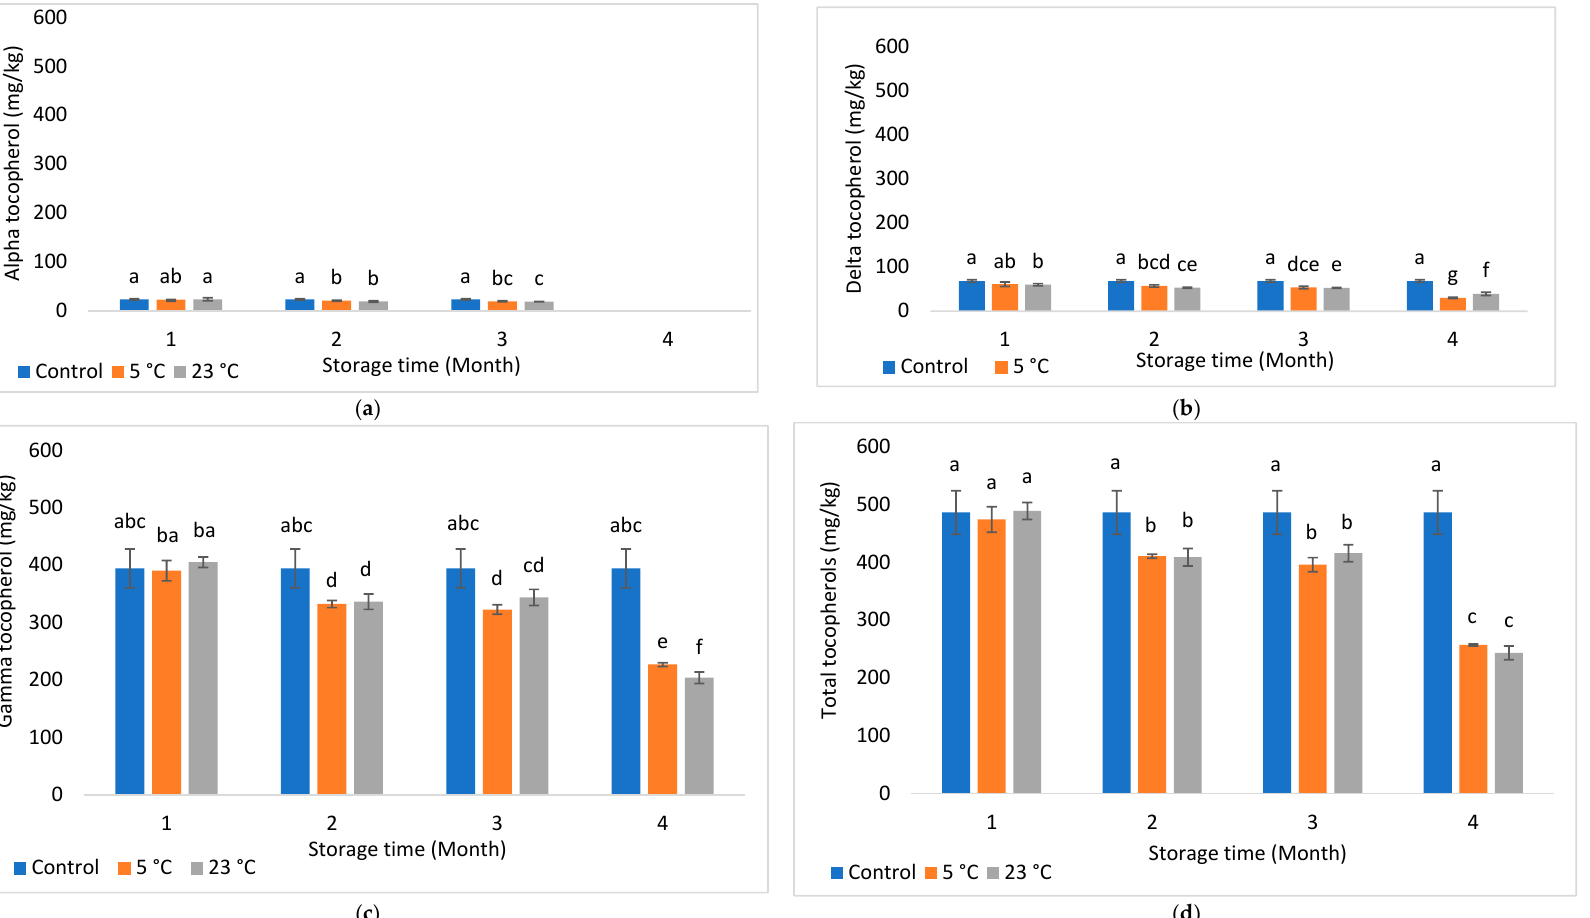
Figure 1. ( a – d ) Changes in alpha ( a ), delta ( b ), gamma ( c ), and total tocopherol ( d ) contents of Howard oil along storage. Different letters within indicate significant differences ( p < 0.05) for storage time and month.